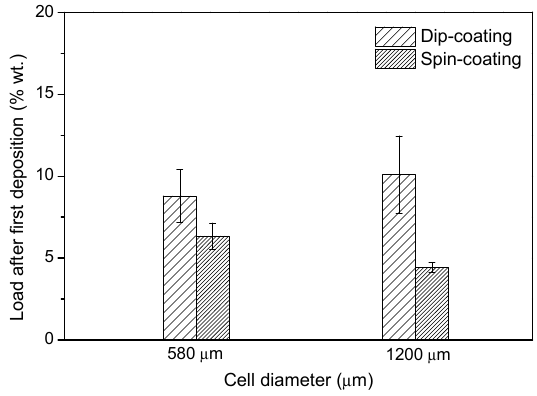
Figure 4. Average washcoat load after one deposition as a function of support cell diameter.